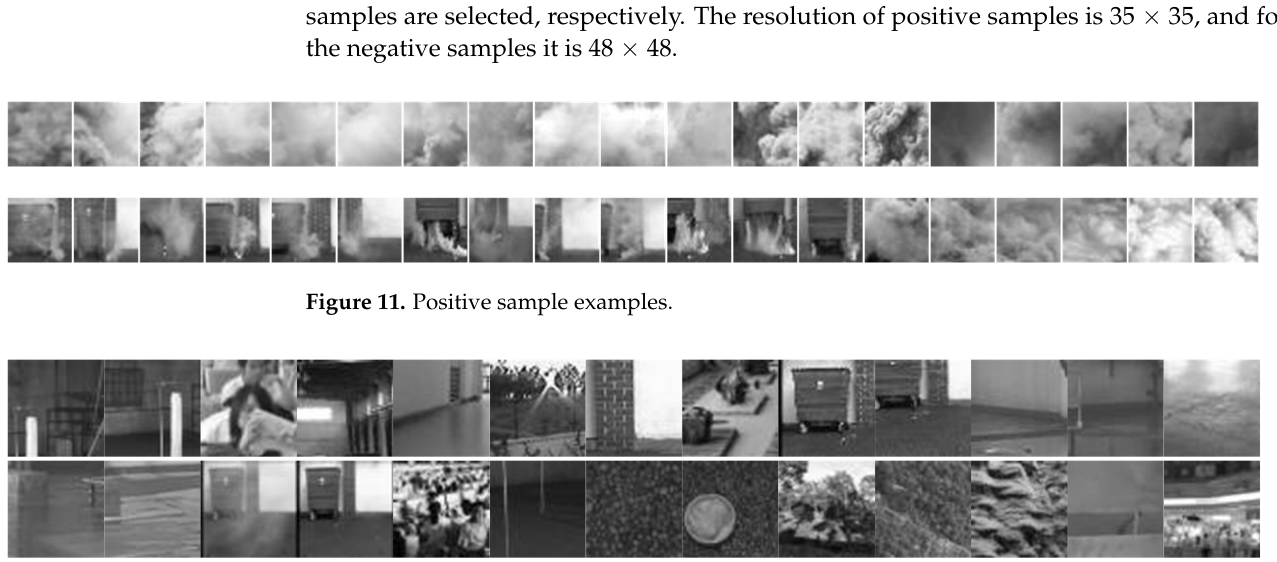
Figure 12. Negative sample examples.